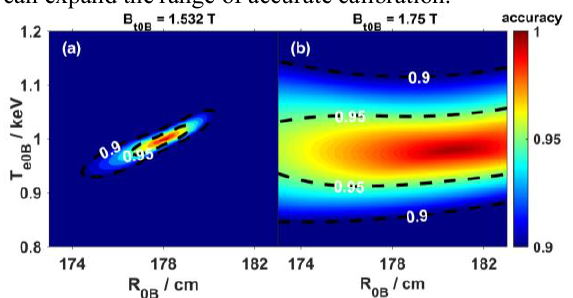
Fig. 6. The dependence of calibration accuracy on R 0B and T e0B when (a) B t0B = 1.532 T and (b) B t0B = 1.75 T, where T e0A = 1 keV, R 0A = 178 cm, and B t0A = 1.5